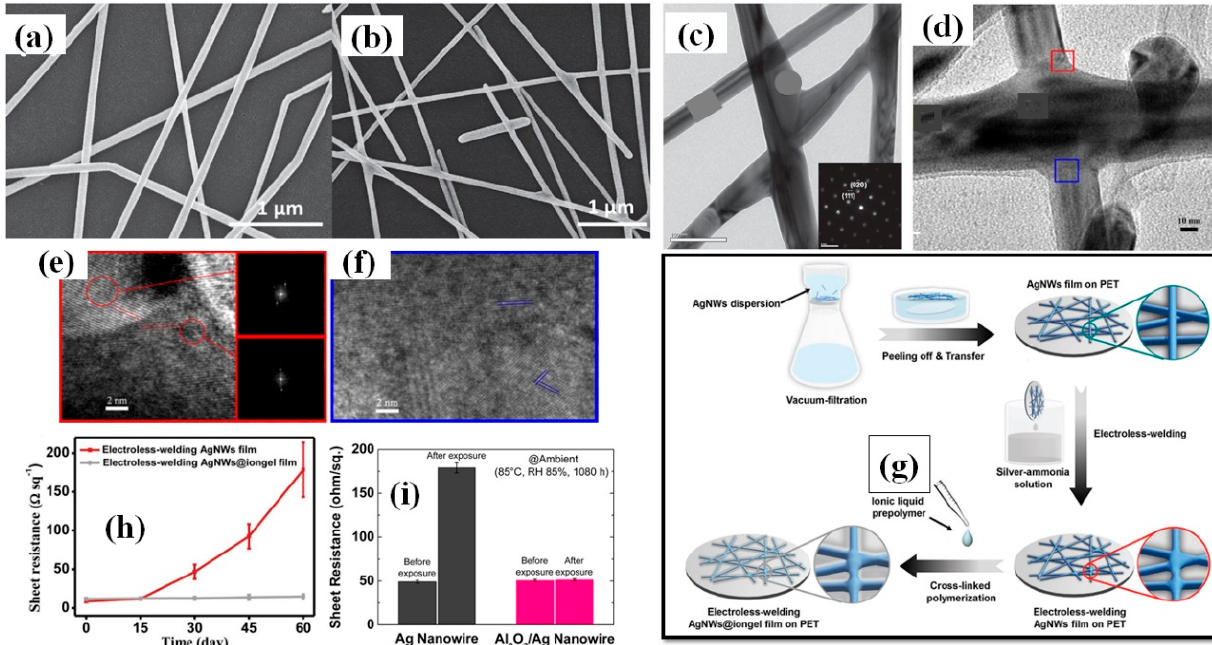
Figure 22. SEM images of transparent electrodes fabricated from 100 nm AgNWs ( a ) before and ( b ) after chemical treatment, ( c ) TEM image of crossed AgNWsafter chemical treatment better junction can be seen (adapted from [243] with permission from John and Wiley sons 2015). ( d ) Plane view TEM image of the welded junction between AgNWs. The frames represent the approximate positions of the welded junction for the lattice-resolved TEM in ( e – f ). Lattice-resolved TEM images of the upper ( e ) and lower ( f ) interfaces between the bottom AgNW and the junction, respectively. The upper right and lower right insets in ( e ) present FFT patterns from the bottom AgNW and the junction, respectively, which are different from each other. Lattice orientation of the junction in ( f ) mismatches that of the bottom AgNW. (adapted from [244] with permission from ACS publications, 2017). ( g ). Fabrication of stable AgNWs@iongel composite films for flexible transparent electrodes. ( h ) The sheet resistance of the electroless-welding AgNWs@iongel film shows tiny change even after exposure in air under ambient conditions for two months, while the sheet resistance of AgNW film without iongel sharply increases after 30 days(adapted from [247] with permission from John and Wiley sons 2016). ( i ) Sheet resistances of the Ag and Al2O3/Ag nanowire electrodes before and after exposure to ambient conditions with a relative humidity of 85% at 85 °C for 1080 h (adapted from [248] with permission from Springer, 2017). 3.2.7. Light Induced Welding Light induced welding has been utilized as a simple and time efficient post-treatment method to improve AgNW based TCE performance. The intensity of the light and treat- ment time are two important parameters while using light induced welding methods. Some researchers have studied the effect of sunlight to enhance the properties of the TCE [249]. The light intensity was controlled by a solar simulator, and could be further en- hanced by using light converging lenses. They exposed the fabricated electrode to sunlight for 4 h to enhance the NW-NW junction contact and the results were satisfactory (T ~87% and R s < 20 Ω /sq). However these results were superior to the results of thermal annealing at 200 °C as presented in Figure 23a. Silver nanostructures are susceptible to light; various morphological changes have been observed when they are exposed to various light sources [250]. Lee et al. demonstrated that a selective laser nano-welding was much more efficient in terms of processing speed as well as thermal controllability, as compared to broadband lamp welding. Since lasers are monochromatic sources of light whereby pho- ton energy can be controlled, the treatment temperature can be accurately controlled de- pending on the substrate used. The occurrence of surface Plasmon resonance of nanowires and enhancement in electrical properties at the NW-NW junction can be seen in the FE- SEM images in Figure 23b. It is worth mentioning that the results obtained from the laser nanowelding technique were far better than those resulting from annealing at 250 °C, as shown in Figure 23c. High intensity pulsed light sintering technique can also be used in order to attain good electrical conductivity in a short time period. Jiu et al. fabricated an